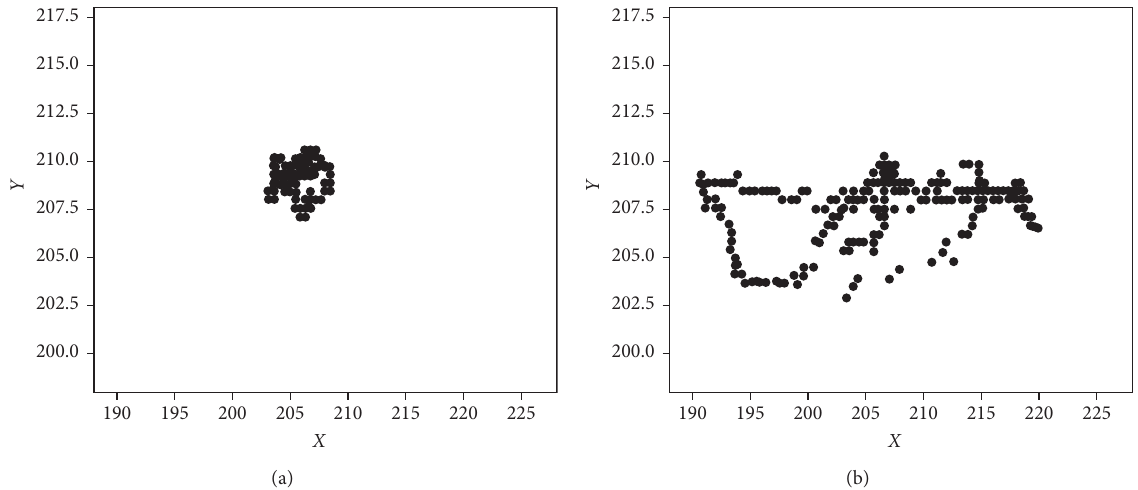
Figure 9: Different drive state facial motion feature point set. Facial motion feature point set in (a) fatigue and. (b